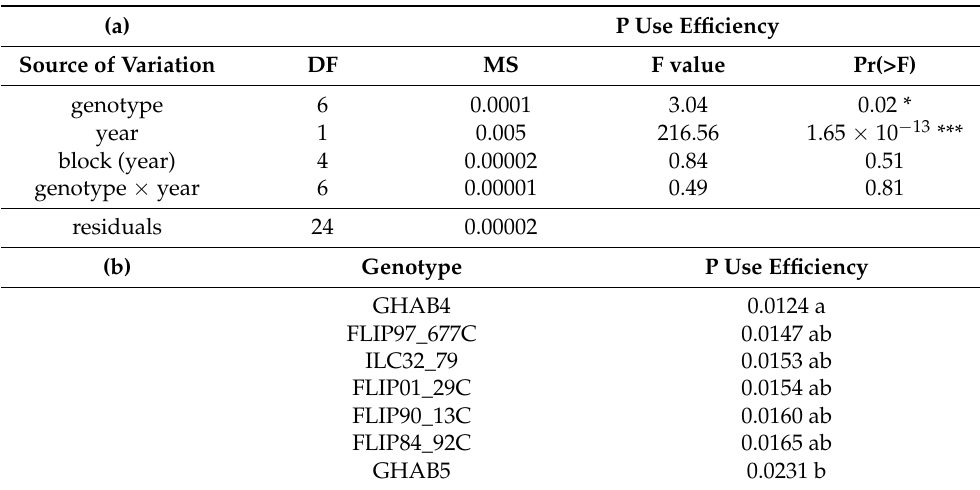
Field experiments with the seven genotypes of chickpea were conducted in random complete block design (RCBD), with three blocks during two growing seasons, from 2018 to 2019, under a P-deficiency soil. Data for the PUE for the N fixation (i.e., ratio of the nodule biomass: nodule P content, expressed in (mg NDW (mg kg − 1 ) − 1 ) were recorded at the flowering stage and analyzed using a two-way ANOVA with interaction with a fixed effects model. Letters identify significantly different groups, according to the Tukey test for the multiple mean comparisons at p = 0.05. P, phosphorus; DF, degree of freedom; MS, mean square; Pr(>F), P-value; NDW, nodule dry